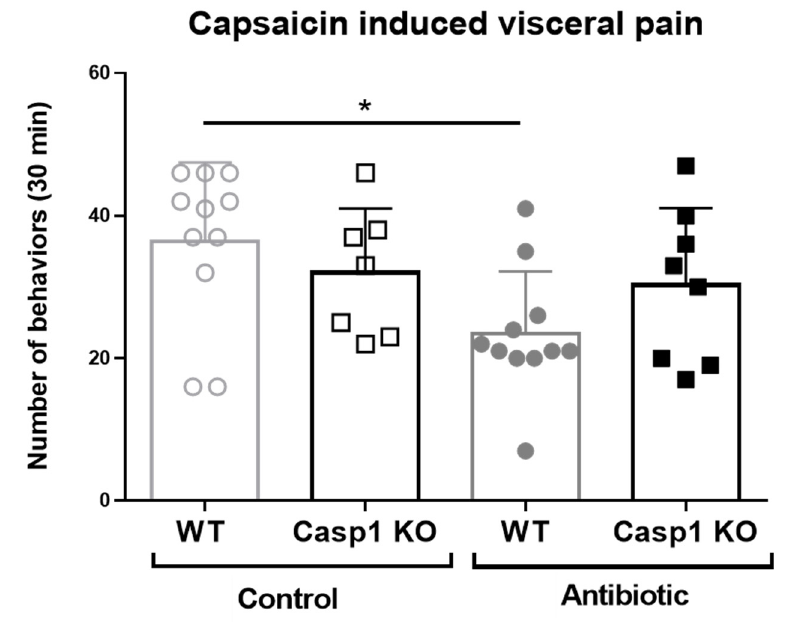
Figure 6. Representative number of visceral pain behaviors during 30 min per each experimental group upon intracolonic administration of capsaicin. Data mean (SD), * p < 0.05 compared to the WT control group. n = 7–11/group, including in all groups, males (range 2 to 8) and females (range 3 to 5).